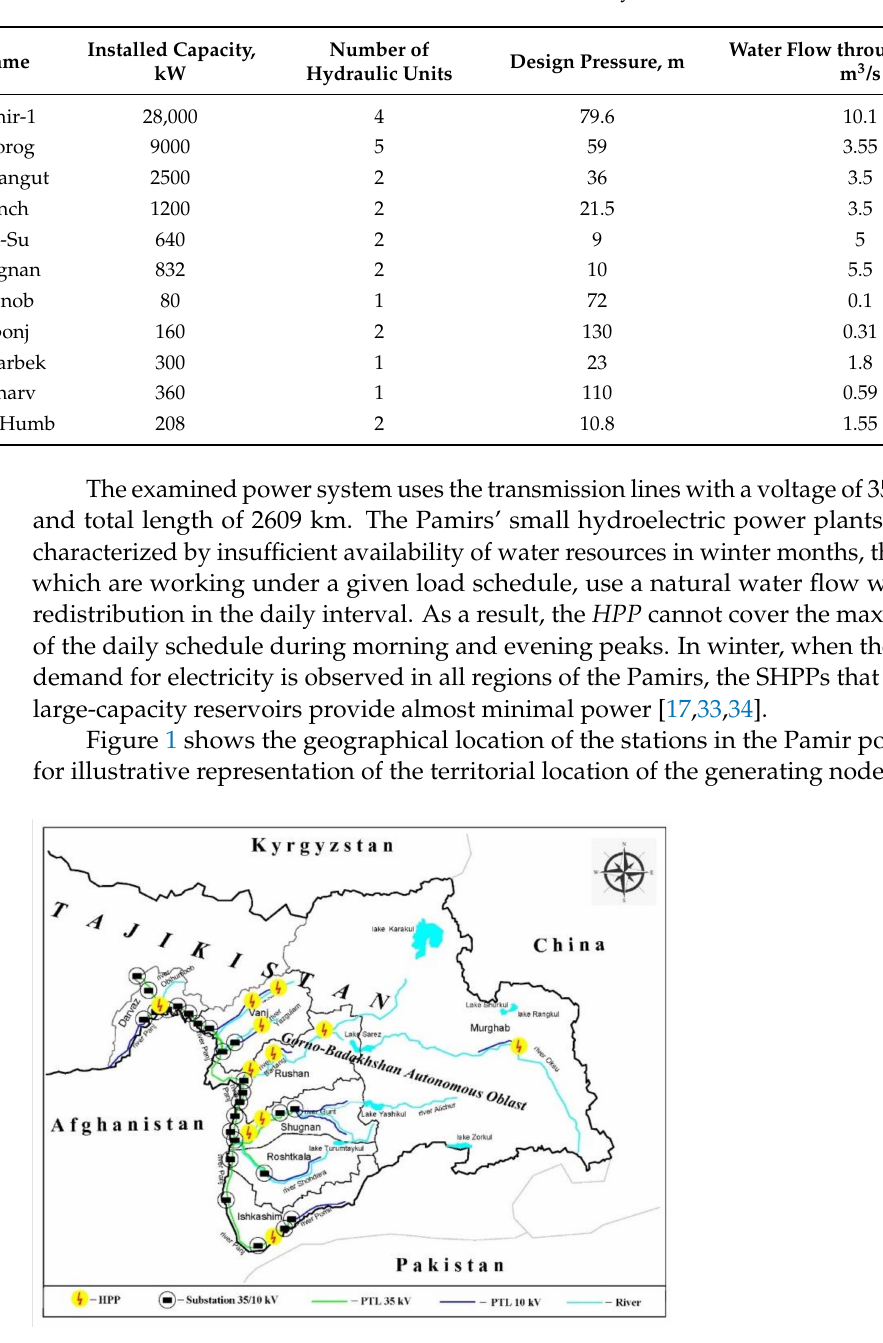
Figure 1. Geographical location of the Pamir power energy